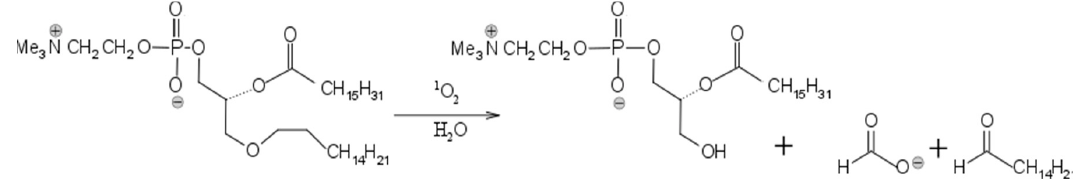
Figure 11. Singlet oxygen-mediated photo-oxidation of plasmalogen vinyl ether linkage.